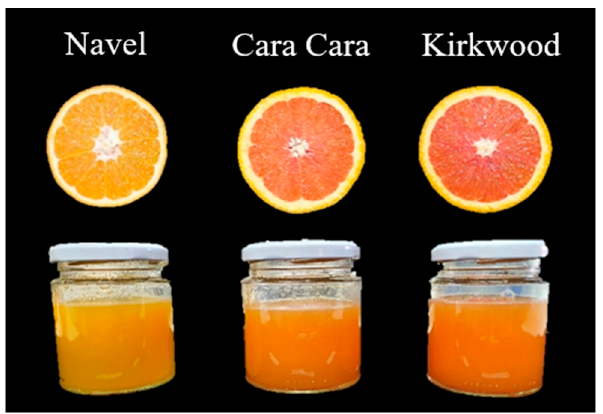
Figure 1. Appearance of pulp and freshly hand-squeezed juice of the sweet orange Navel and the red-fleshed Cara Cara and Kirkwood oranges.